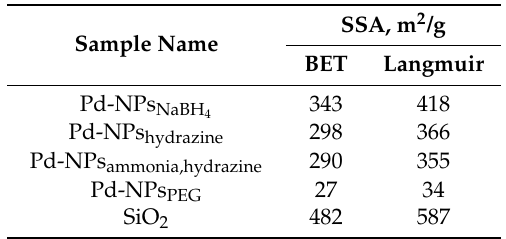
Figure 3. Experimental (solid colored lines) and theoretical (dashed black lines) diffraction patterns for Pd/SiO 2 samples reduced in NaBH 4 ( orange ); in hydrazine ( blue ); in hydrazine with ammonia ( red ); and in PEG ( green ). Dashed vertical lines highlight the positions of Pd Bragg reflections and SiO 2 reflection. Table 2. Specific surface area (SSA) for the synthesized Pd/SiO 2 NPs and SiO 2 support. BET: